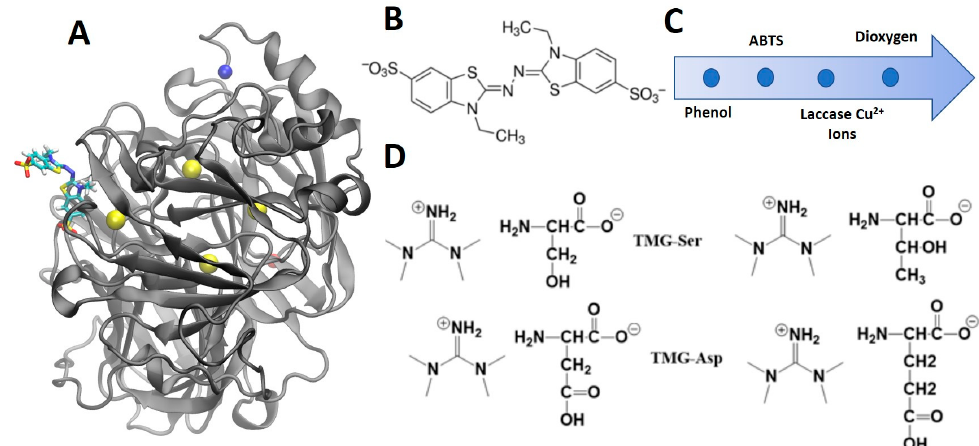
Figure 1. Structure of laccase, ABTS and ionic liquids and the electron transfer chain of the laccase catalysis. ( A ) Tertiary crystal structure of laccase (PDB ID: 1GYC). Protein backbone: Grey ribbons. ABTS ligand: Licorice tubes colored by element. Cu 2+ ions: Yellow VDW balls. N-terminus: Red VDW ball. C-Terminus: Blue VDW ball. T1 Cu 2+ ion (left) is adjacent to ABTS; T2 Cu 2+ ion (right) is parallel across from T1 Cu 2+ ion. T3 Cu 2+ ions (top and bottom) are perpendicular to the T1 and T2 Cu 2+ ions. ( B ) Chemical structure of ABTS. ( C ) The putative electron transporting chain in the redox catalysis mechanism of laccase. Order of electron flow is from left-to-right: an electron is passed from a phenol to ABTS and laccase Cu 2+ ions before reducing dioxygen to water. ( D ) Chemical structures of the ionic liquids TMG-Ser, TMG-Thr, TMG-Asp and